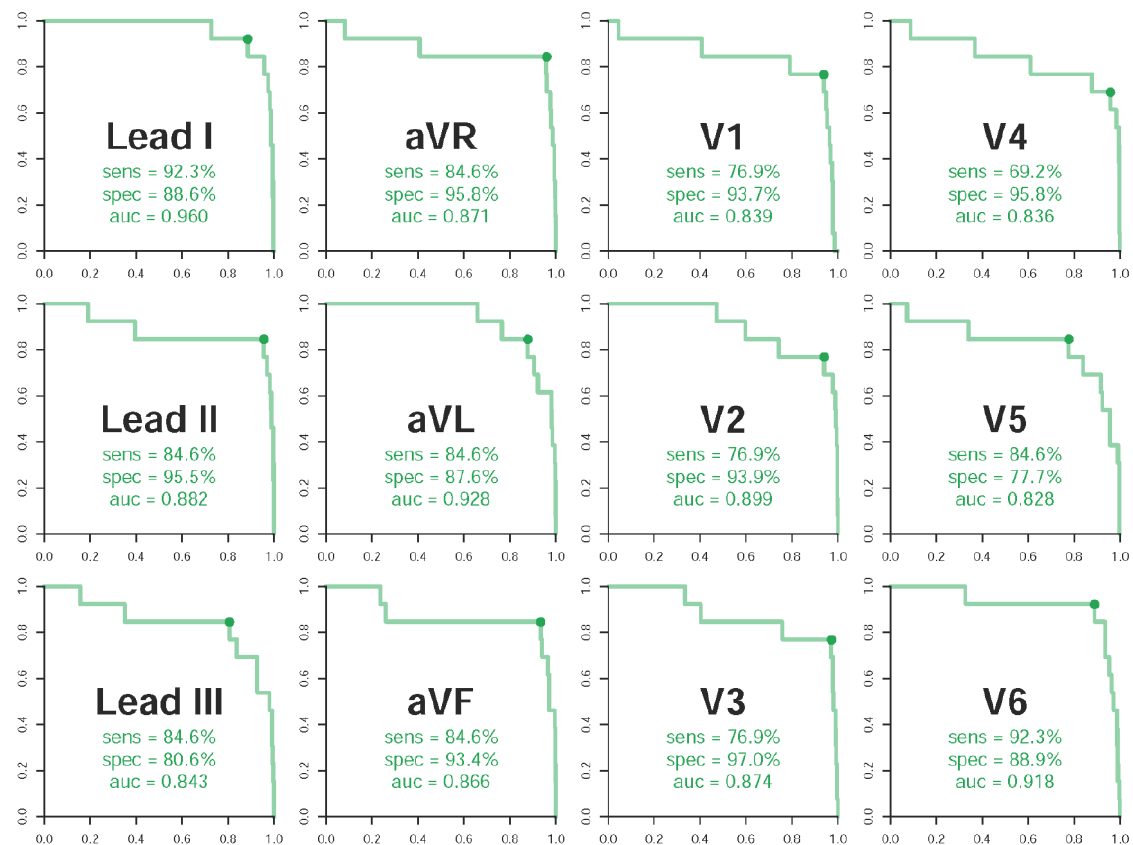
Figure 3. Lead-specific ROC (Receiver operating characteristic) curves in the validation cohort. ROC curves with specificity on the x -axis and sensitivity on the y -axis. The cases were defined as the digoxin toxicity ECGs, and the controls were defined as the normal ECGs.